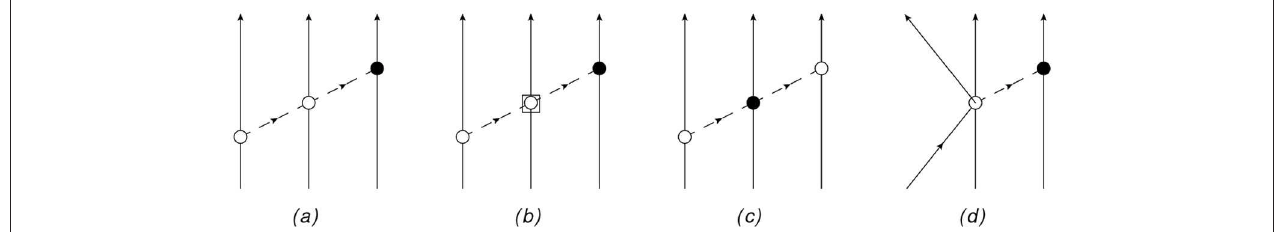
FIGURE 3 | TOPT diagrams that would contribute to the PVTC 3N force For the notation see Figure 1